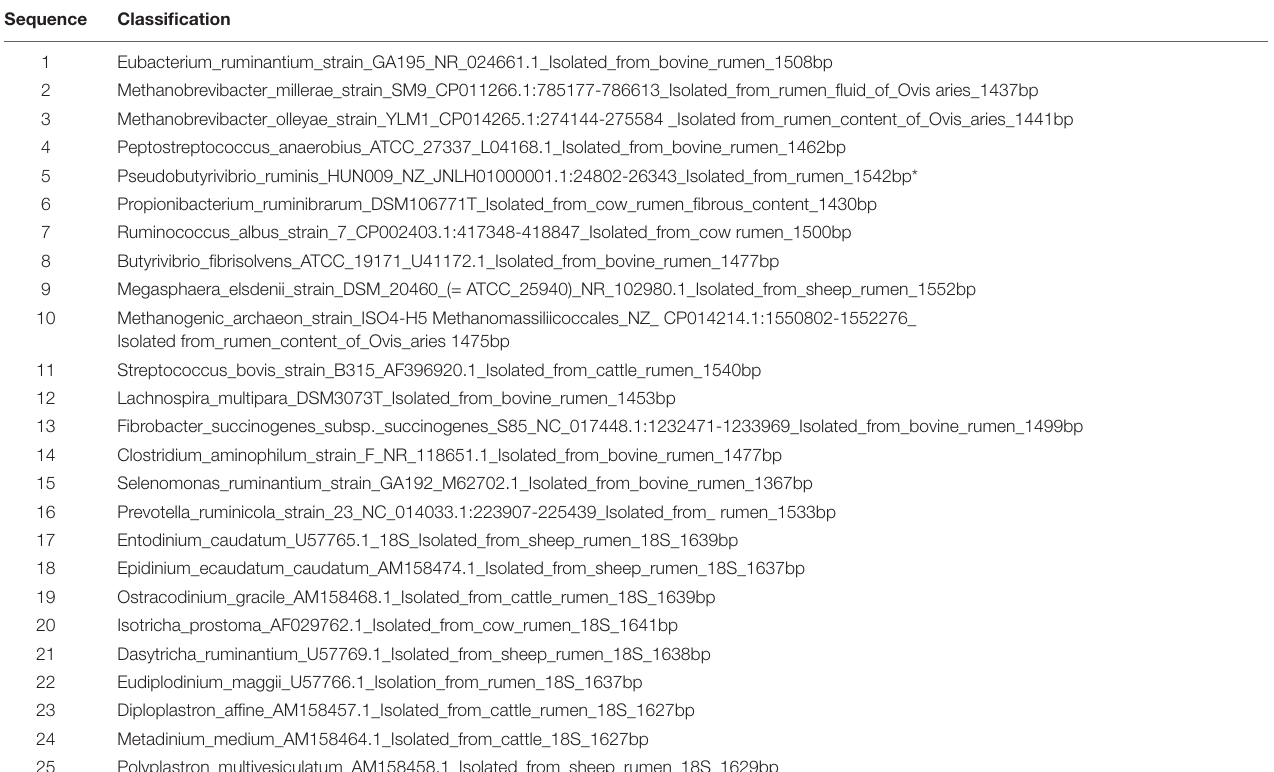
TABLE 1 | Classification of full length 16S (bacteria and archaea; n = 16) and 18S (protozoa; n = 9) rRNA sequences included in the rumen specific reference